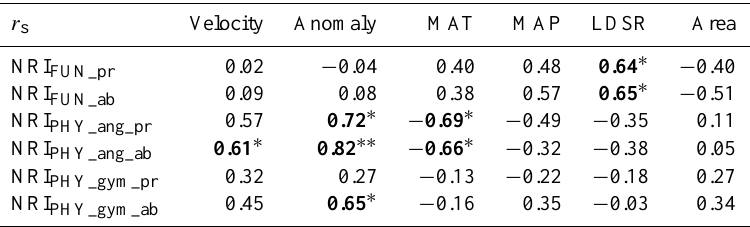
Table 1. Spearman correlations ( r s ) between each diversity index and each explanatory variable. NRI FUN : functional ( H max ) NRI, and NRI PHY : phylogenetic NRI, based on either presence–absence ( pr ) or abundances ( ab ) with gymnosperms ( gym ) or only considering an- giosperms ( ang ) . Significant values are given in bold; ∗ p < 0 . 05; ∗∗ p < 0 . 01.